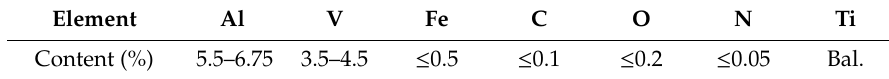
Table 1. The composition of the Ti-6Al-4V